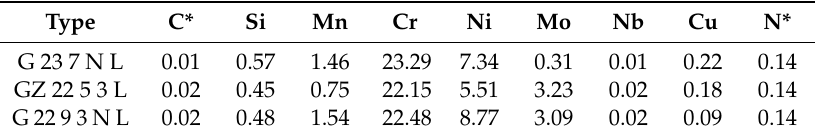
Table 1. Chemical composition (in wt.%) of the filler metals determined by optical emission spectroscopy and carrier gas melt extraction*.